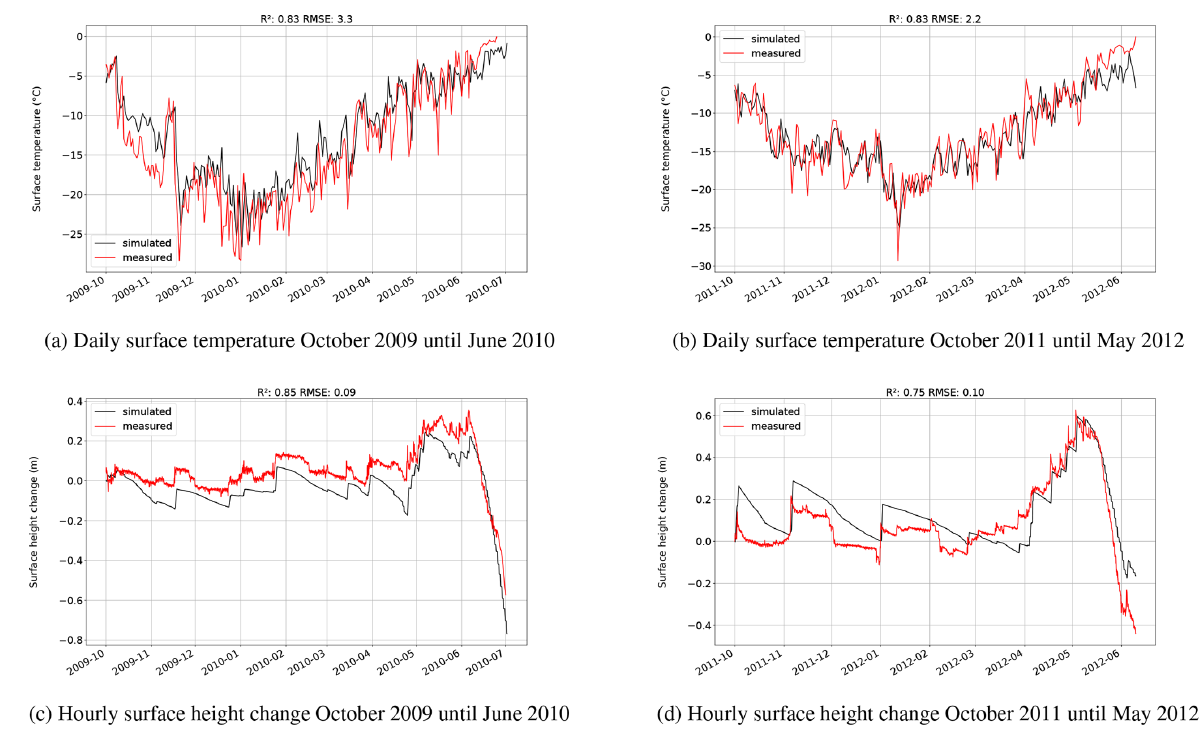
Figure 1. Simulated and measured surface temperatures and surface height changes (in both cases, permanent snow cover) at the location of the automatic weather station at the Zhadang glacier. Table 1. Observed and simulated ice ablation (mmw.e.) for three periods at the automatic weather station on the Zhadang